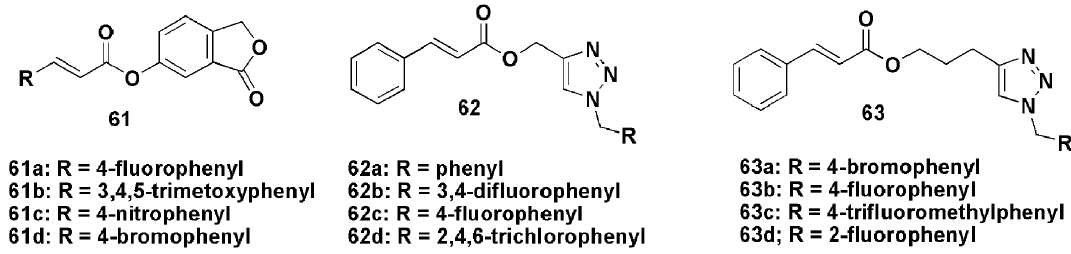
Figure 17. Chemical structures of compounds 61 – 63 ( a–d ) [3].